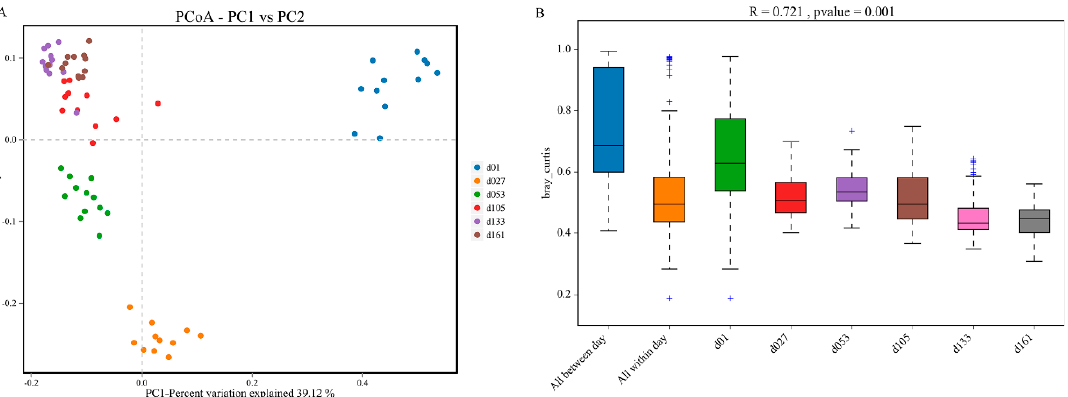
Figure 2. Dynamic changes of cecal microbiota alpha diversity with age in Wenchang chickens. ( A ) Chao1 index; ( B ) Shannon index. Different letters represent significant differences in alpha diversity indices based on Student’s t -test (* p < 0.05, ** p < 0.01). d01, n = 12; d027, n = 11; d053, n = 12; d0105, n = 12; d133, n = 12; d161, n = 12.